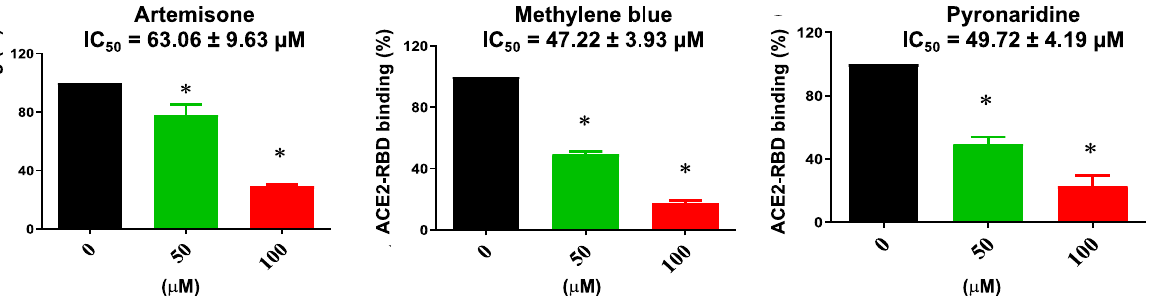
Figure 7. Results of ELISA experiments demonstrating that pyronaridine, artemisone and methylene blue inhibit the binding of RBD to ACE2 (* p < 0.05, compared with control group).